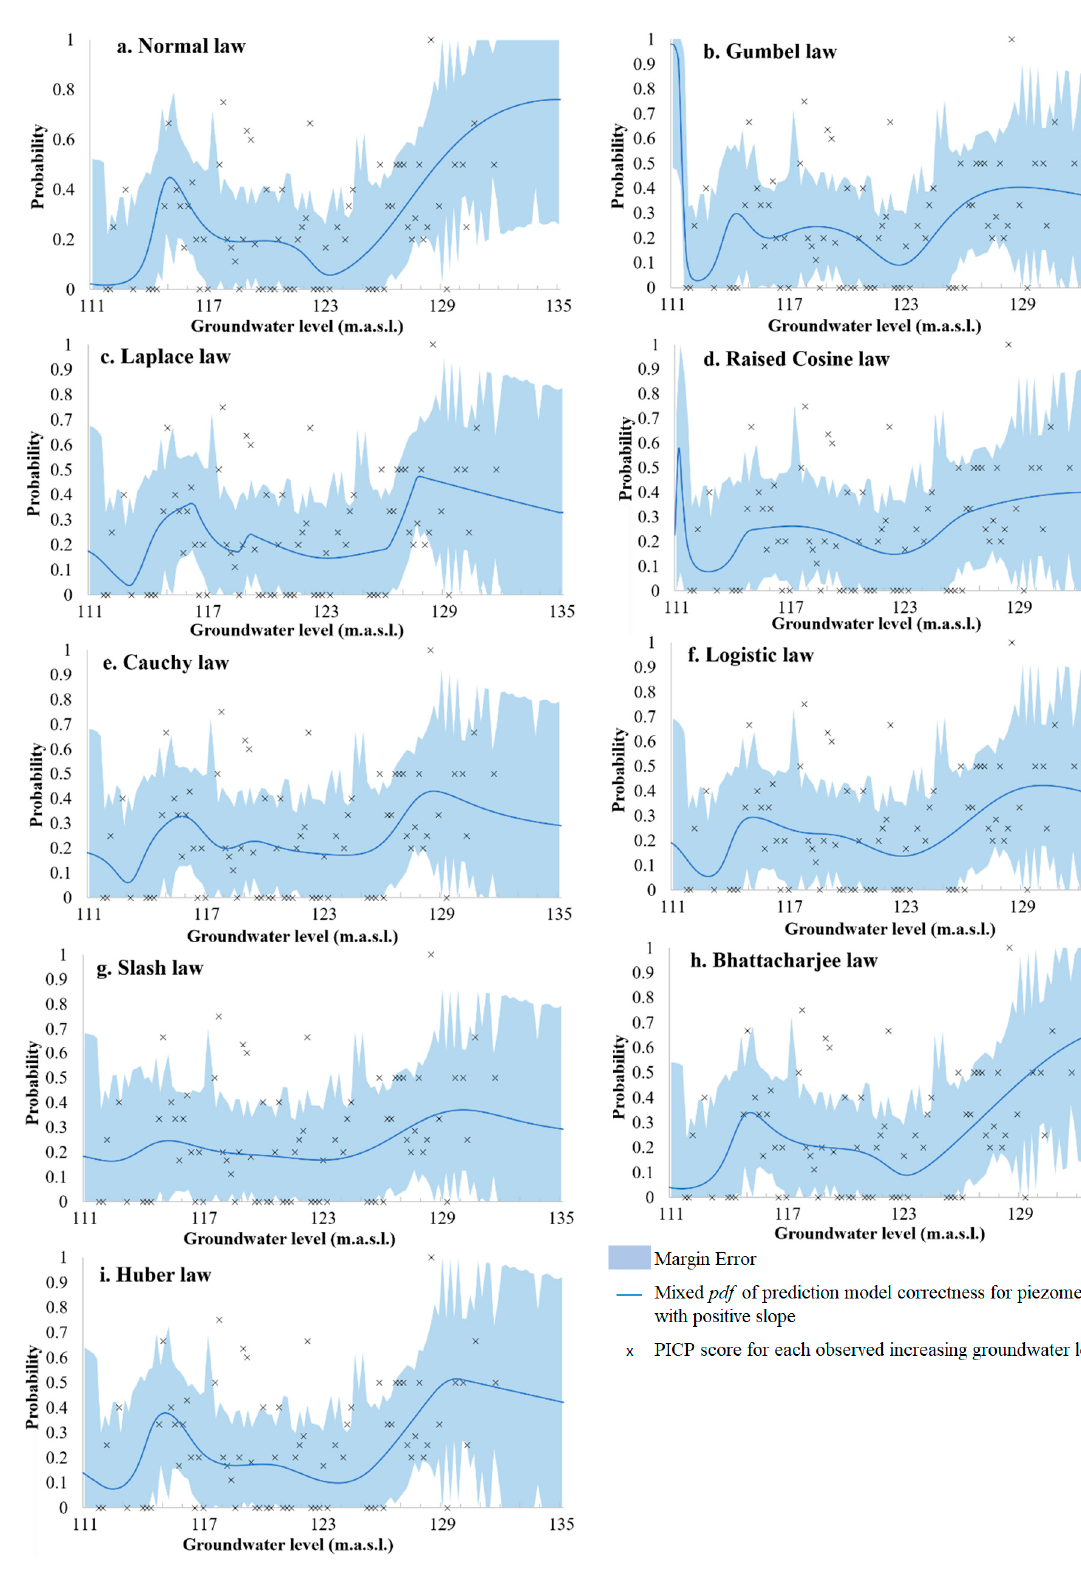
Figure 10. Models of correctness and Error margin ( M E ), calculated from composite pdf of increasing levels and using a confidence index of 95% for ( a ) Normal law, ( b ) Gumbel law, ( c ) Laplace law, ( d ) Raised Cosine law, ( e ) Cauchy law, ( f ) Logistic law, ( g ) Slash law, ( h ) Bhattacharjee law and ( i ) Huber law. The same kind of models of correctness are made for decreasing groundwater levels, shown in Figure 11.